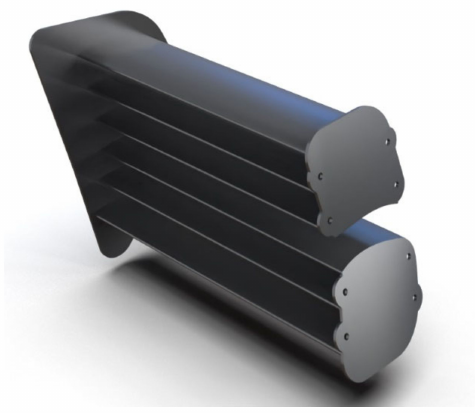
Figure 3. Example of shutter-like fairing structure.